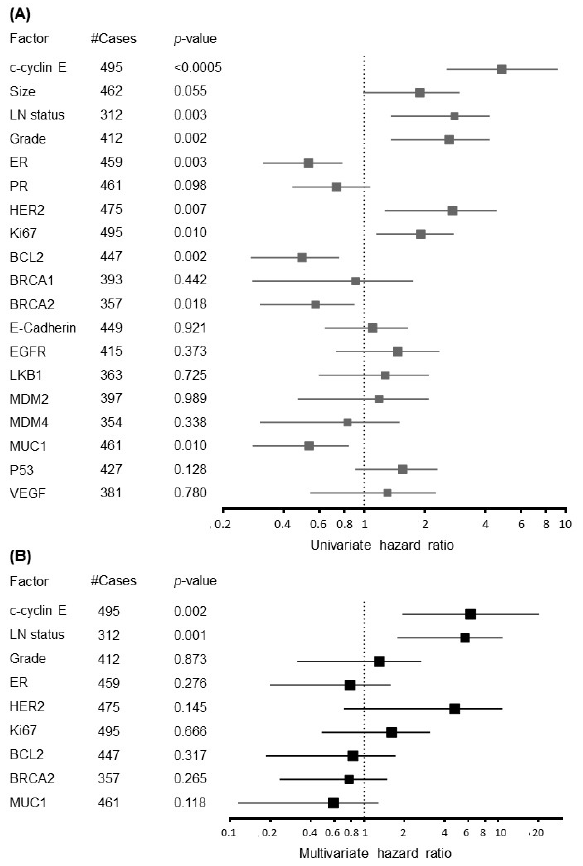
Figure 5. ( A ) Univariate and ( B ) multivariate analysis of c-cyclin E with clinicopathological and age-associated biomarkers.